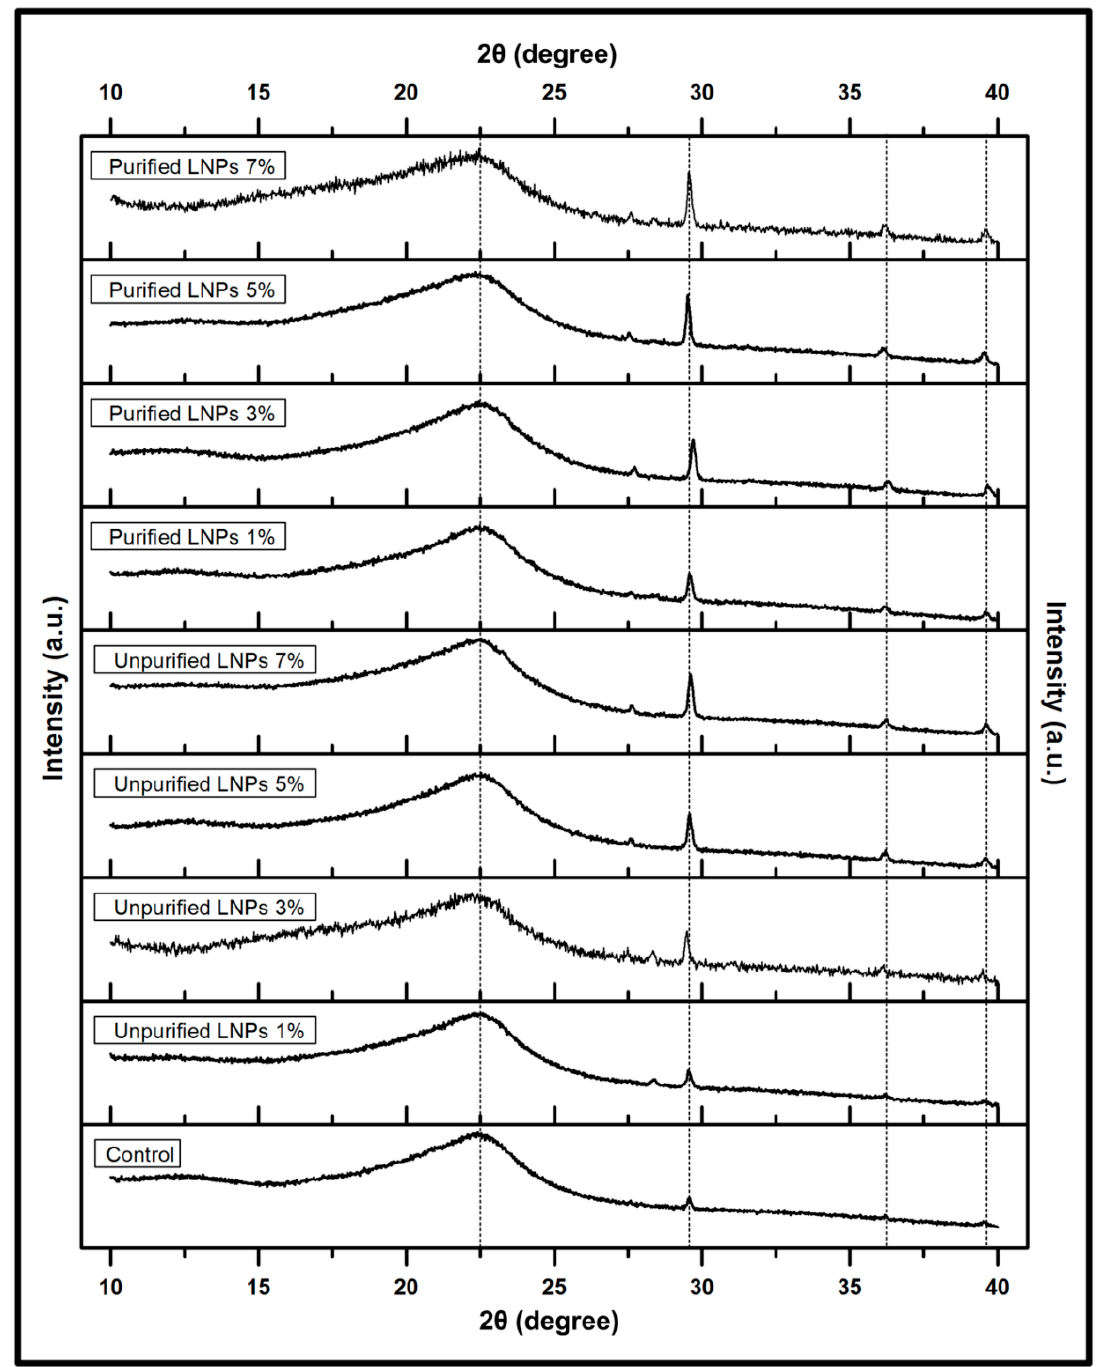
Figure 4. XRD patterns of control film and unpurified/purified LNP-reinforced bioplastic films.